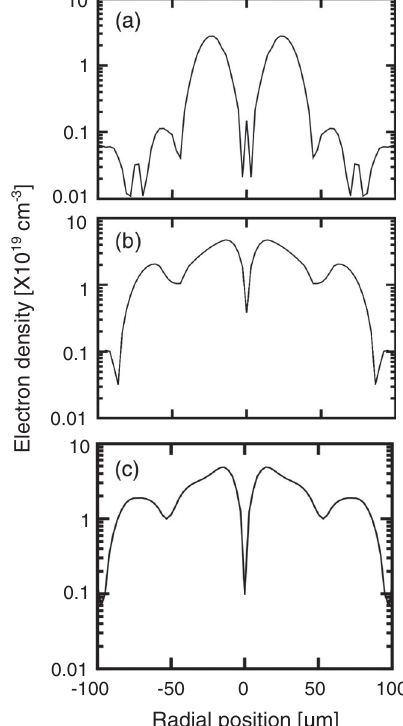
FIG. 9. Transverse cross section of density profiles at different positions: A, B, and C as in Fig. 6(d).